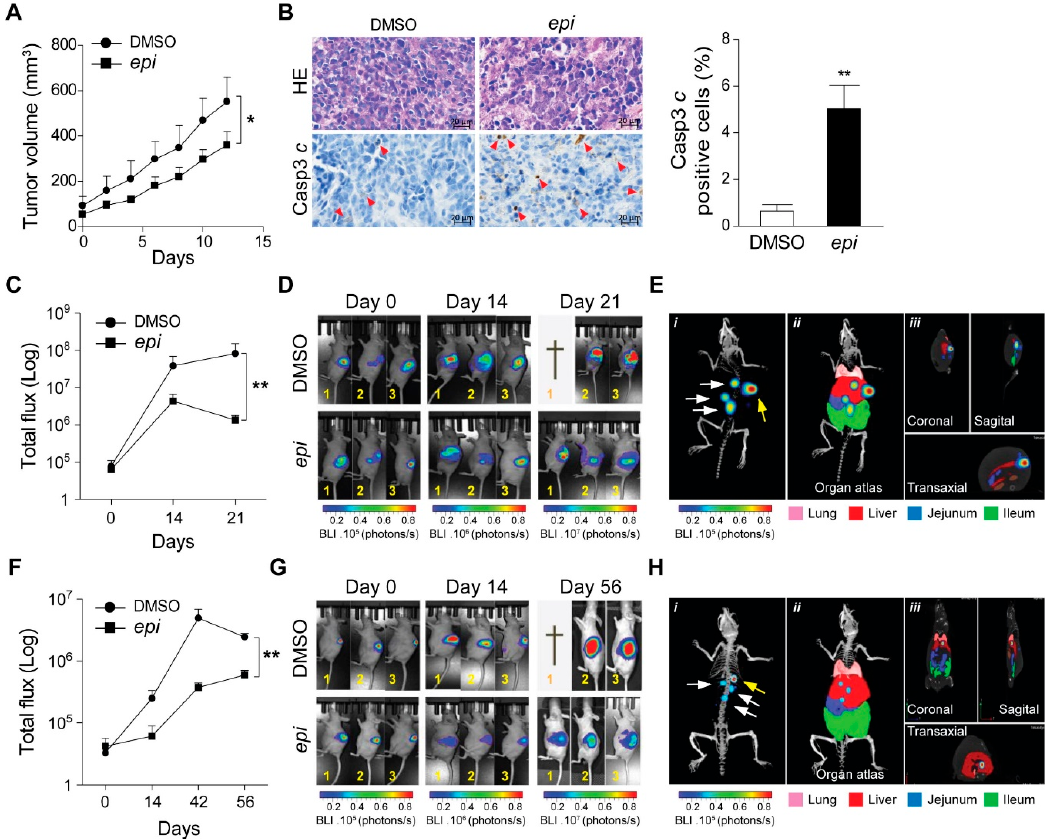
Figure 4. Epi -enprioline reduces tumour growth in vivo. ( A ) Nude mice were injected with 2 × 10 6 VCR-20 cells. When the mice developed visible subcutaneous tumours using caliper (100–125 mm 3 ), they were treated intra-tumour, 2–3 cm away from the tumour, with 10 mg/kg of epi-enprioline or DMSO control ( n = 6 mice in each group). The mean tumor volume for each treatment group was graphed plus/minus standard errors (* p < 0.05). ( B ) Immunohistochemistry analysis of tumour biopsies isolated from control (Ctrl) or epi -enprioline-treated VCR-20 cells using haemotoxylin and eosin or antibodies against cleaved caspase-3. Arrowheads indicate cleaved caspase-3 positive cells (left panel). Quantification of the number of cleaved caspase-3 (Asp175) positive cells in the sections isolated from control and epi -enprioline-treated group (Right panel, mean ± SEM, ** p < 0.01, n = 3). ( C ) Nude mice were subjected to orthotopic implantation into adrenal gland with VCR-20-GFP-Luc cells (1 × 10 6 ) and a week later, the tumor growth was monitored by non-invasive 2D bioluminescence (BLI) imaging using IVIS-CT spectrum. Mice ( n = 6) showing tumor growth signals were randomized into DMSO and epi -enprioline treatment groups. BLI signal intensity was quantified in Total flux (Photons/s) after deducting the average background signal (Bkg) from measurement region of interest (ROI) using the Living image analysis software (mean ± SEM, ** p < 0.01). ( D ) Representative images of tumor growth (VCR-20 GFP-Luc cells) in mice treated with DMSO or epi -enprioline, † indicates animal not surviving the entire study period. ( E ) Ventral side 3D µCT representative images were taken to show distant metastasis of VCR-20 Luc cells in control animals after orthotopic implantation into adrenal gland. Site of implantation is shown by yellow arrowhead. The mouse organ atlas (ii and iii) was overlaid on the 3D skeletal image (i) to show the possible metastatic anatomical sites (white arrowheads) using Living image analysis software. ( F ) Nude mice were subjected to orthotopic implantation into adrenal gland with LU-NB-2 GFP-Luc (2 × 10 6 ). One week later, the tumor growth was monitored by non-invasive 2D bioluminescence (BLI) imaging, using IVIS-CT spectrum. Mice ( n = 6) showing tumor growth signals were randomized into DMSO or epi -enprioline treatment groups. BLI signal intensity was quantified in Total flux (Photons/s) after deducting the average background signal (Bkg) from measurement region of interest (ROI) using the Living image analysis software